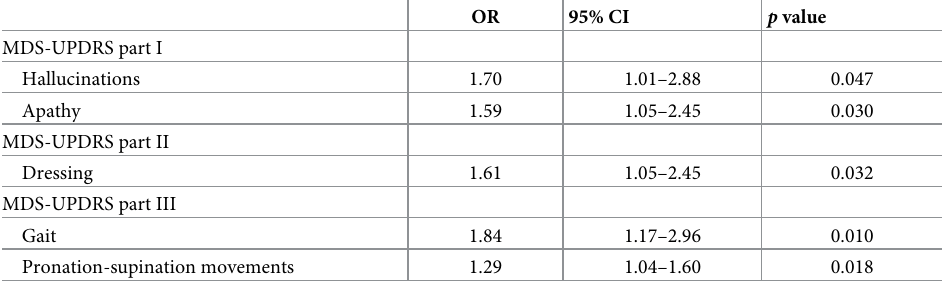
Table 6. Logistic regression analysis of pRBD as evaluated by the Japanese version of the RBD screening question- naire based on the sub-items of each part of the MDS-UPDRS. OR 95% CI p value